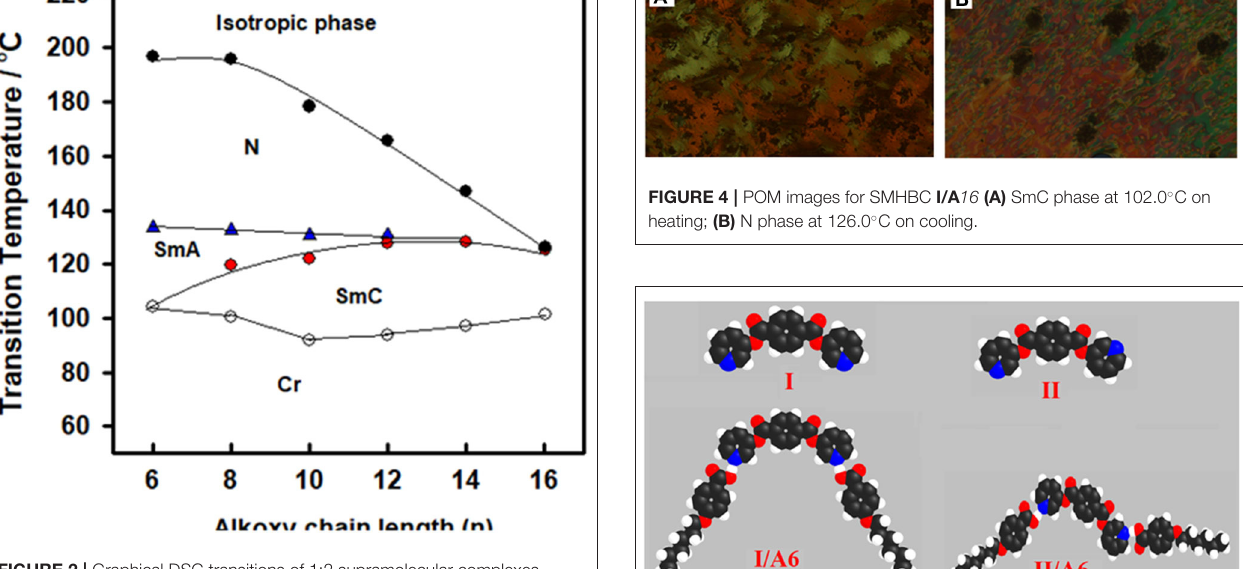
FIGURE 2 | Graphical DSC transitions of 1:2 supramolecular complexes series, I/A n .